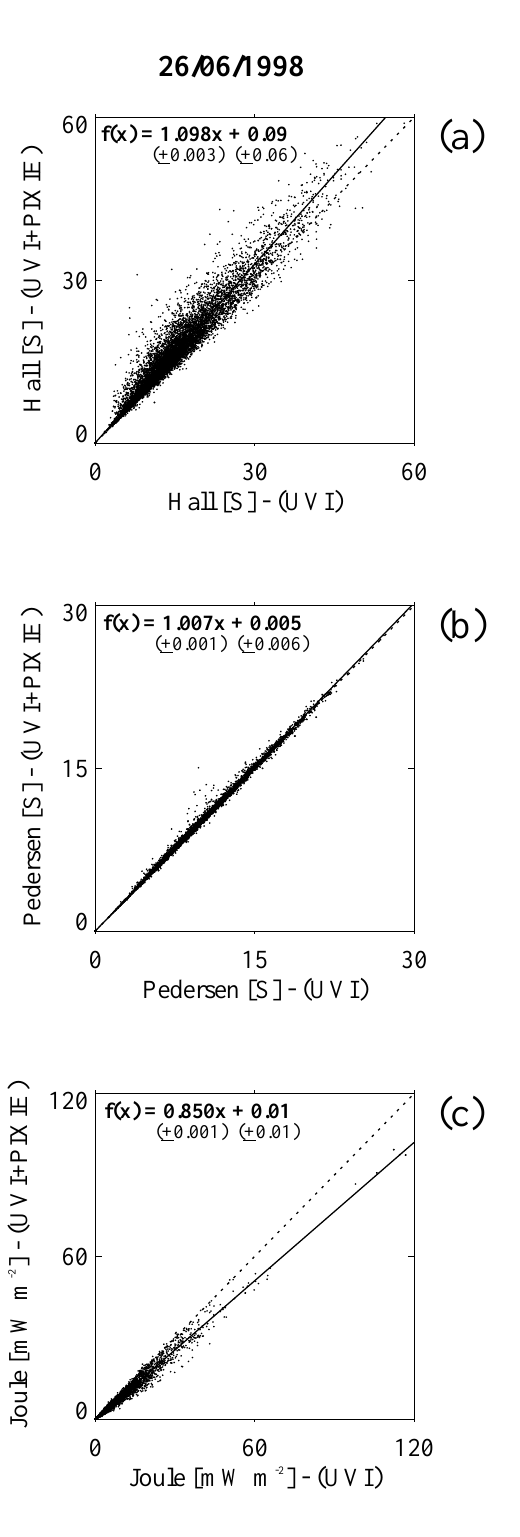
Fig. 7. (a) Hall conductances 6 H , (b) Pedersen conductances 6 P and (c) Joule heating values Q J derived with and without the PIXIE data throughout the time interval between 03:00 and 08:00 UT on 26 June 1998. The data values are taken from the regions covered by the PIXIE and UVI instruments. The solid line results from a linear regression analysis of the data